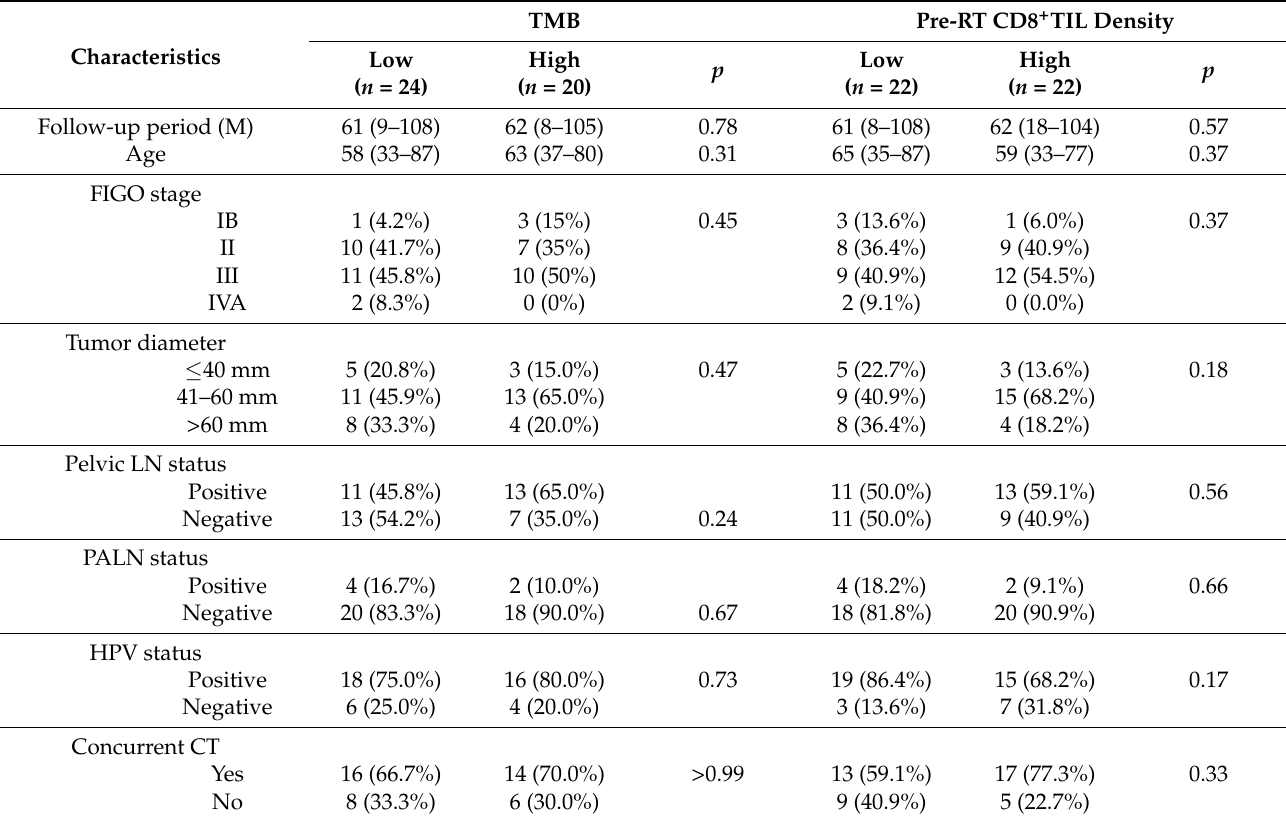
Table 2. Association of TMB or pre-RT CD8+TIL density with patient characteristics.